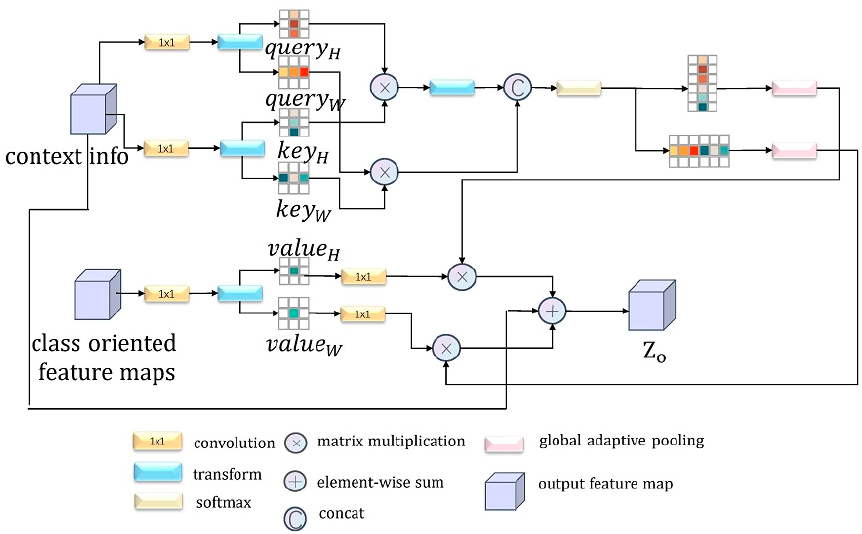
Figure 6. Illustration for the architecture of CCFM.